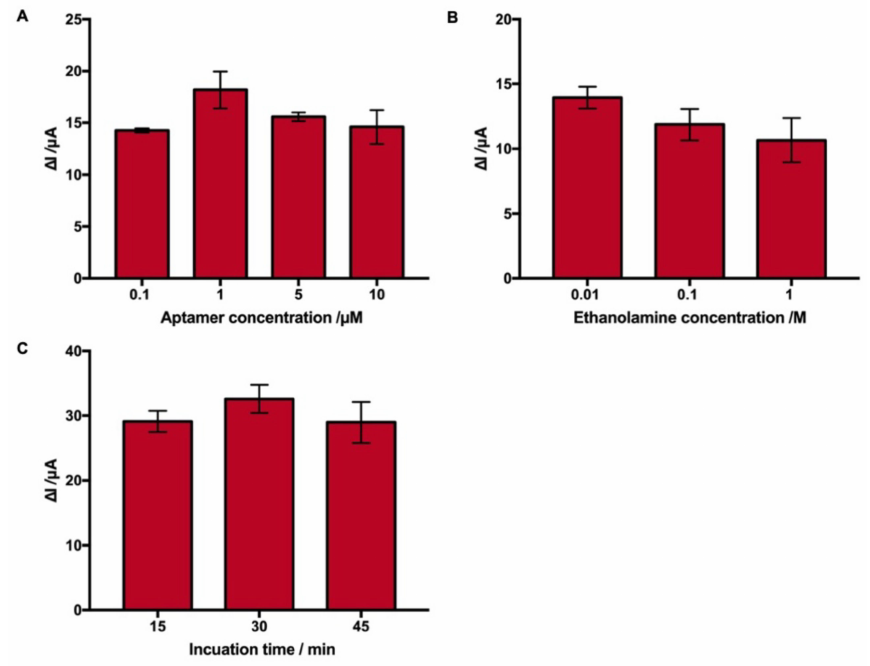
Figure 7. Optimization of ( A ) aptamer concentration, ( B ) concentration of blocking solution, and ( C ) reaction time with GA